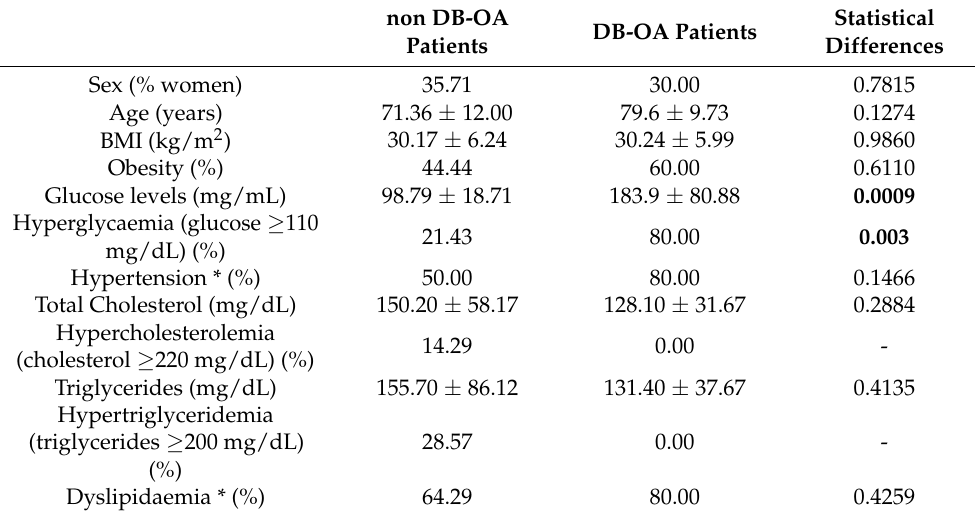
Figure 2. Levels of H 2 S synthesising enzymes in cartilage from osteoarthritic patients with or without diabetes. The protein expression of enzymes involved in H 2 S biosynthesis, ( a ) cystathionine β - synthase (CBS), ( b ) cystathionine γ -lyase (CSE), and ( c ) 3-mercaptopyruvate sulphurtransferase (MPST), was evaluated by western blot in freshly isolated chondrocytes from OA patients without DB (non DB-OA, blue dots; n = 14) or with DB (DB-OA, green dots; n = 10). Additionally, the study population was divided into patients with normoglycaemia or hyperglycaemia and ( d – f ) levels of these enzymes were analysed in these different subsets of patients. Values were mean ± SEM. * p ≤ 0.05 analysed by the Mann–Whitney test. Table 3. Socio-demographic and clinical characteristics of cartilage donors. Columns in the middle show means of values ± SEM or percentage of population per each socio-demographic or clinical variable. Column on the right indicates p-value obtained in the statistical test for a comparison of values for each variable between non DB-OA (n = 14) and DB-OA patients (n = 10) ( p ≤ 0.05 shown in bold, analysed by the Mann–Whitney test). * History of hypertension/dyslipidaemia (altered blood cholesterol and/or triglyceride levels).